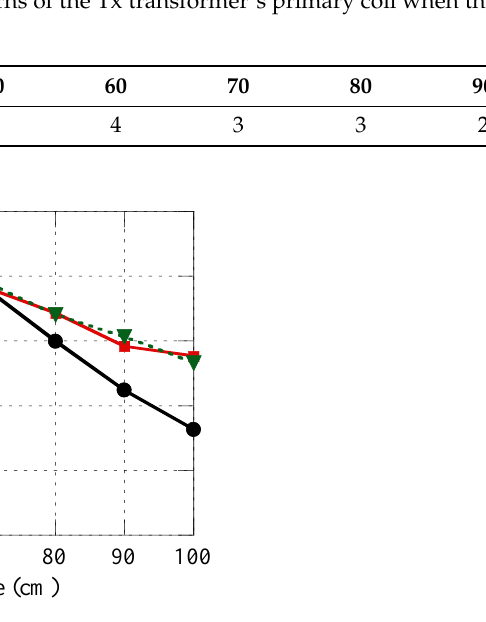
Figure 12. Measured power transfer efficiencies among three impedance matching cases (case 1: with transformers in both sides; case 2: with the combined impedance matching method; case 3: with load impedance matching fixed in case 2).